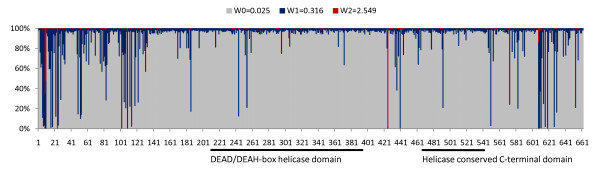
Posterior probabilities of three site classes with different selective pressures (measured by the w ratio) for codon sites along the mammalian PL10 homologs under the site model M3. The X-axis represents the codon positions which were labeled based on the human DDX3X amino acids. The probabilities of the site classes are indicated in the Y-axis. The DEAD/DEAH-box helicase domain and helicase conserved C-terminal domain are underlined.